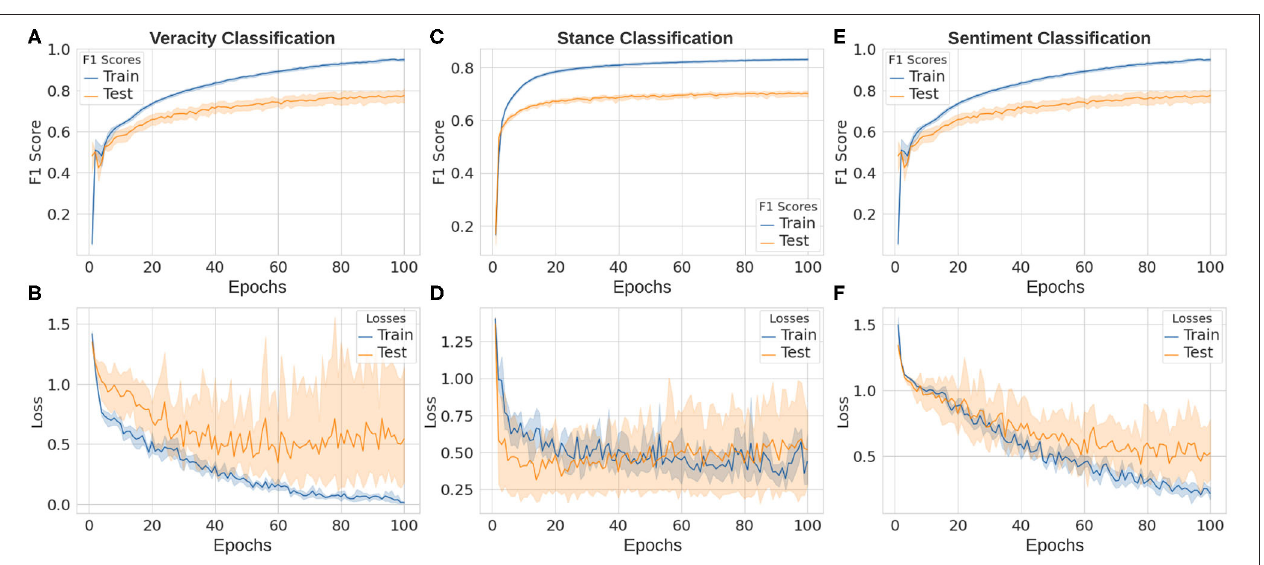
FIGURE 10 | Deep learning results in our rumor classification tasks: veracity classification (A,B) , stance classification (C,D) , and sentiment classification (E,F) .